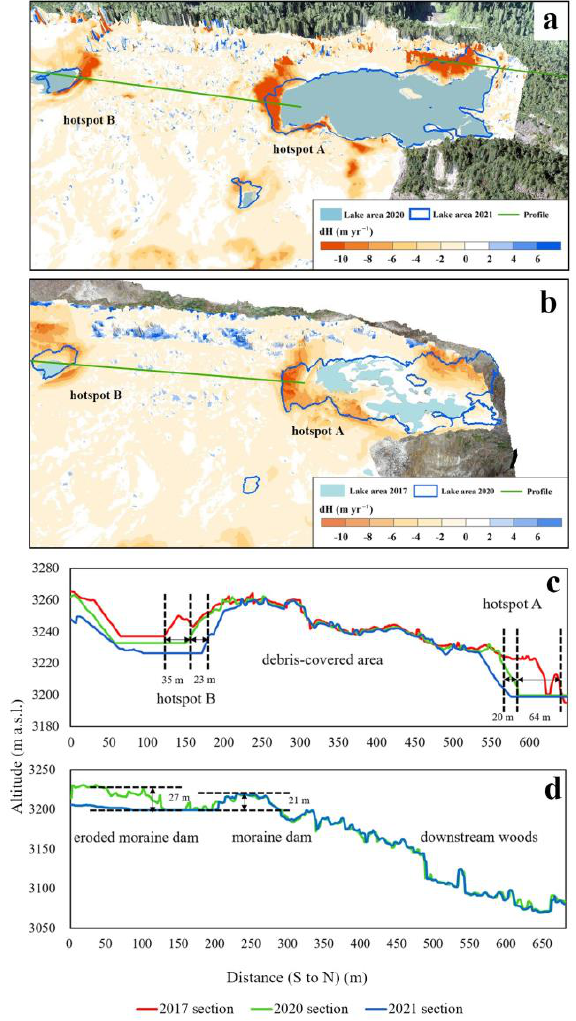
Figure 8. The 3-D textured model and surface elevation change of Zhuxi Glacier terminus between 2020 and 2021 ( a ) and 2017–2020 ( b ). The DEM profile along the transection of hotspot A and hotspot B in 2017, 2020, and 2021 ( c ). The DEM profile along the transection from moraine dam to the valley bottom in 2020 and 2021 ( d ).